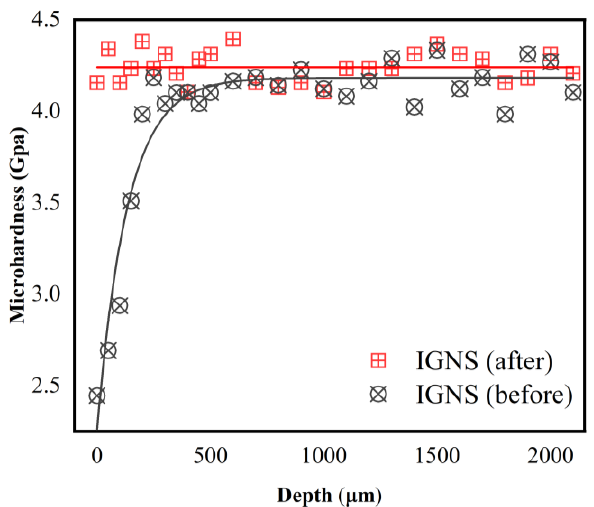
Figure 9. Cross-sectional hardness profiles of the IGNS sample before and after fatigue at a stress amplitude of 700 MPa.